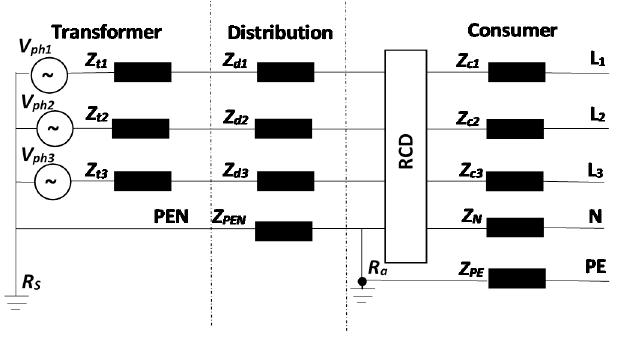
Figure 1. A TN-C-S network.